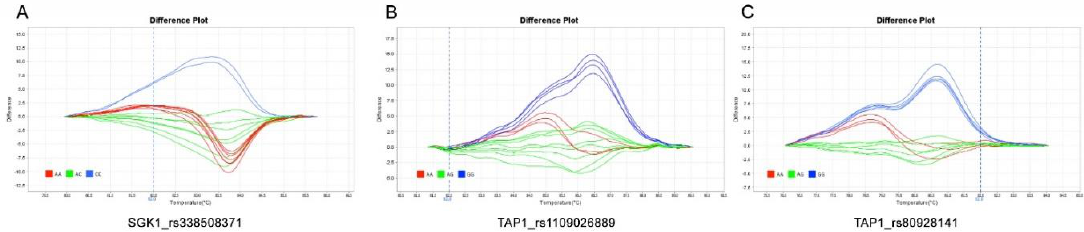
Figure 1. High-resolution melting (HRM) standardised genotyping images of the three tested genotypes. Table 1. Description of SGK1 and TAP1 polymorphisms and allele frequency of the minor allele. Locus